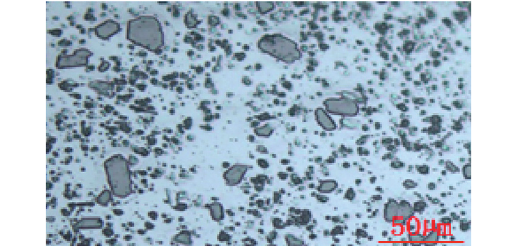
Figure 17: Metallography of traditional network.